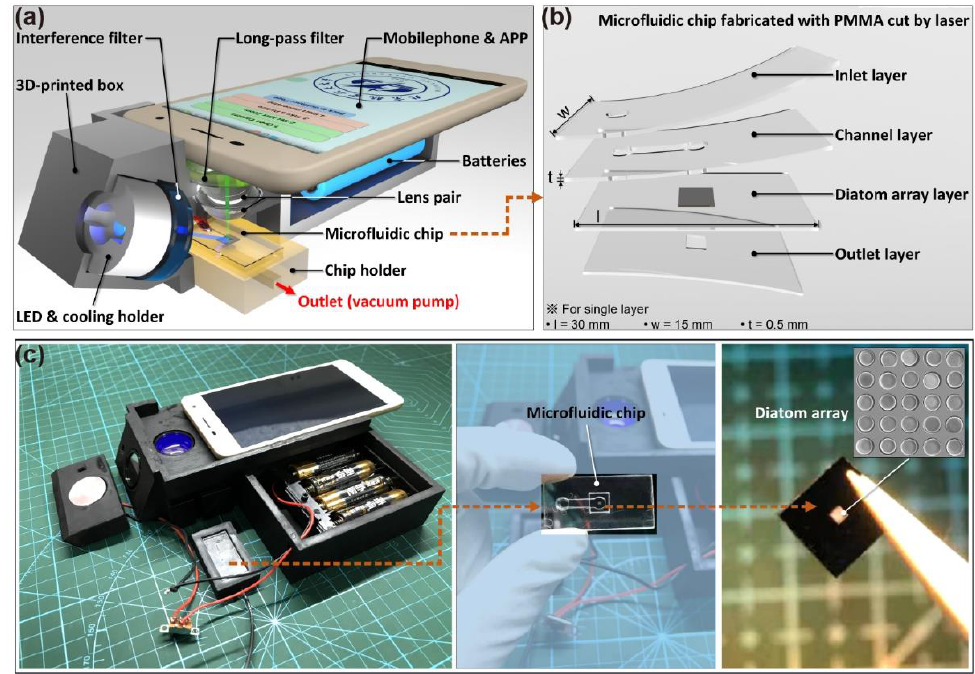
Figure 3. Schematic illustration of ( a ) POCT devices and ( b ) microfluidic chip. ( c ) A picture of the POCT devices.